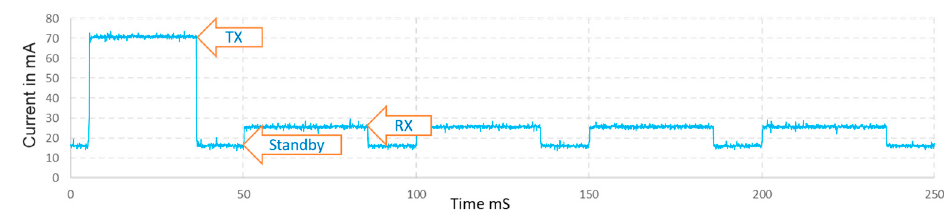
Figure 12. Current measured at 3.3 V in the complete cycle with an average current of 28.6 mA.